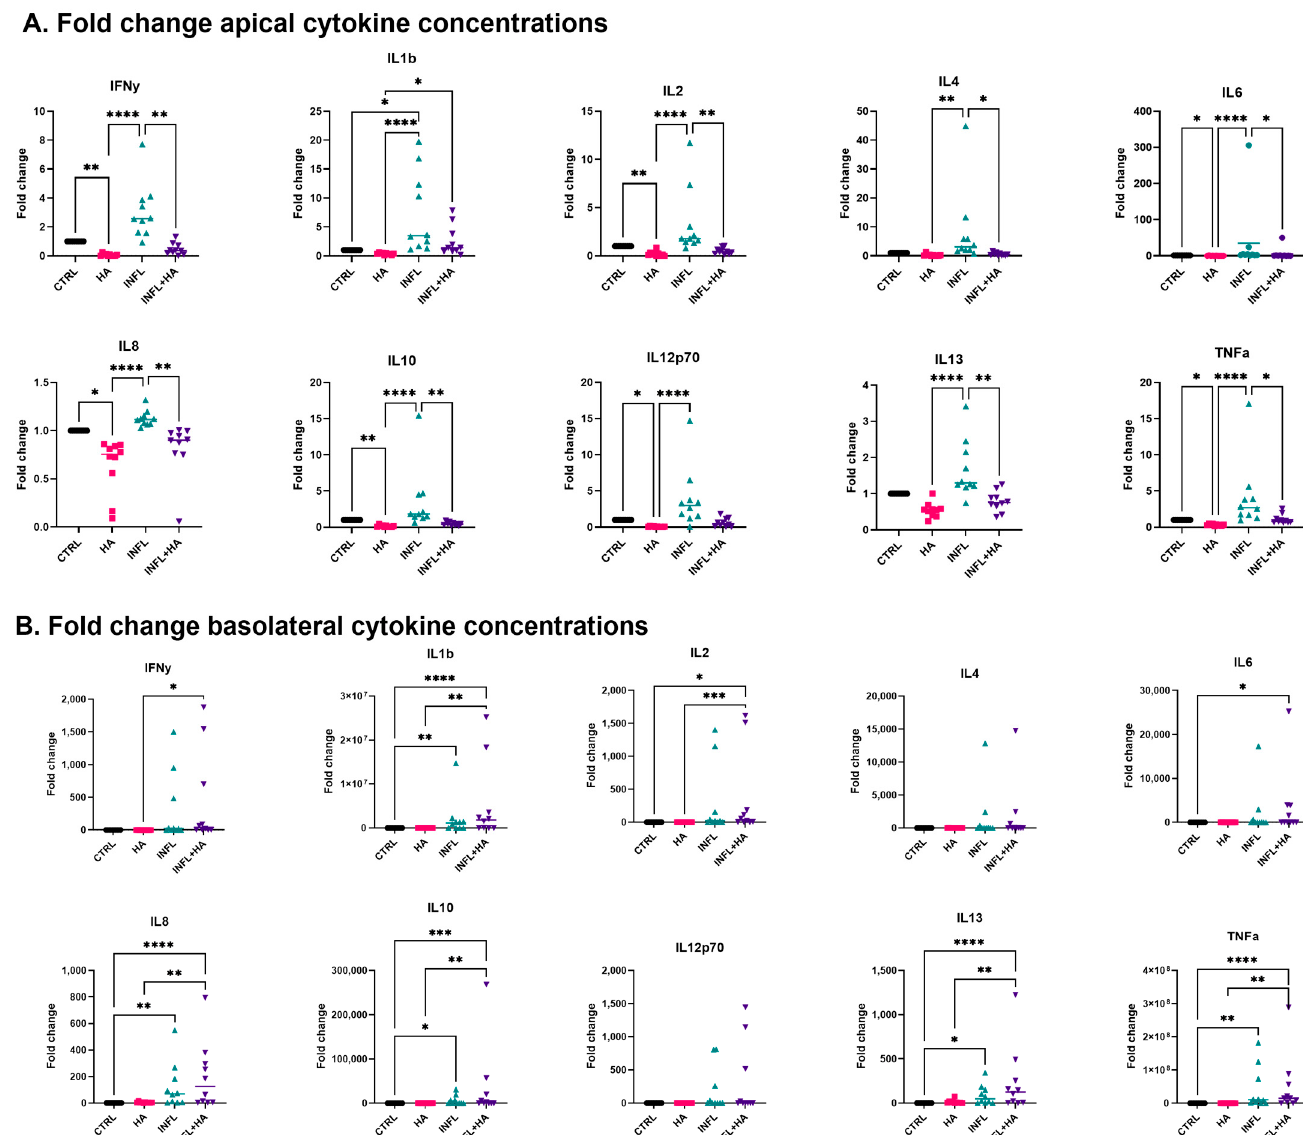
Figure 3. Fold change of proinflammatory cytokine concentrations compared to the respective control, incl. median. All significant and/or clinically relevant p-values (Friedman tests * p < 0.05; ** p < 0.01, *** p < 0.001, **** p < 0.0001) have been added to the figure. Values below detection limit were replaced by half the limit of detection (LOD/2). ( A ) Apical medium. ( B ) Basolateral medium. CTRL = Control medium, INFL = Control medium and inflammatory mix, HA = medium containing 100 mM acetate, INFL + HA = medium containing 100 mM acetate and inflammatory mix.